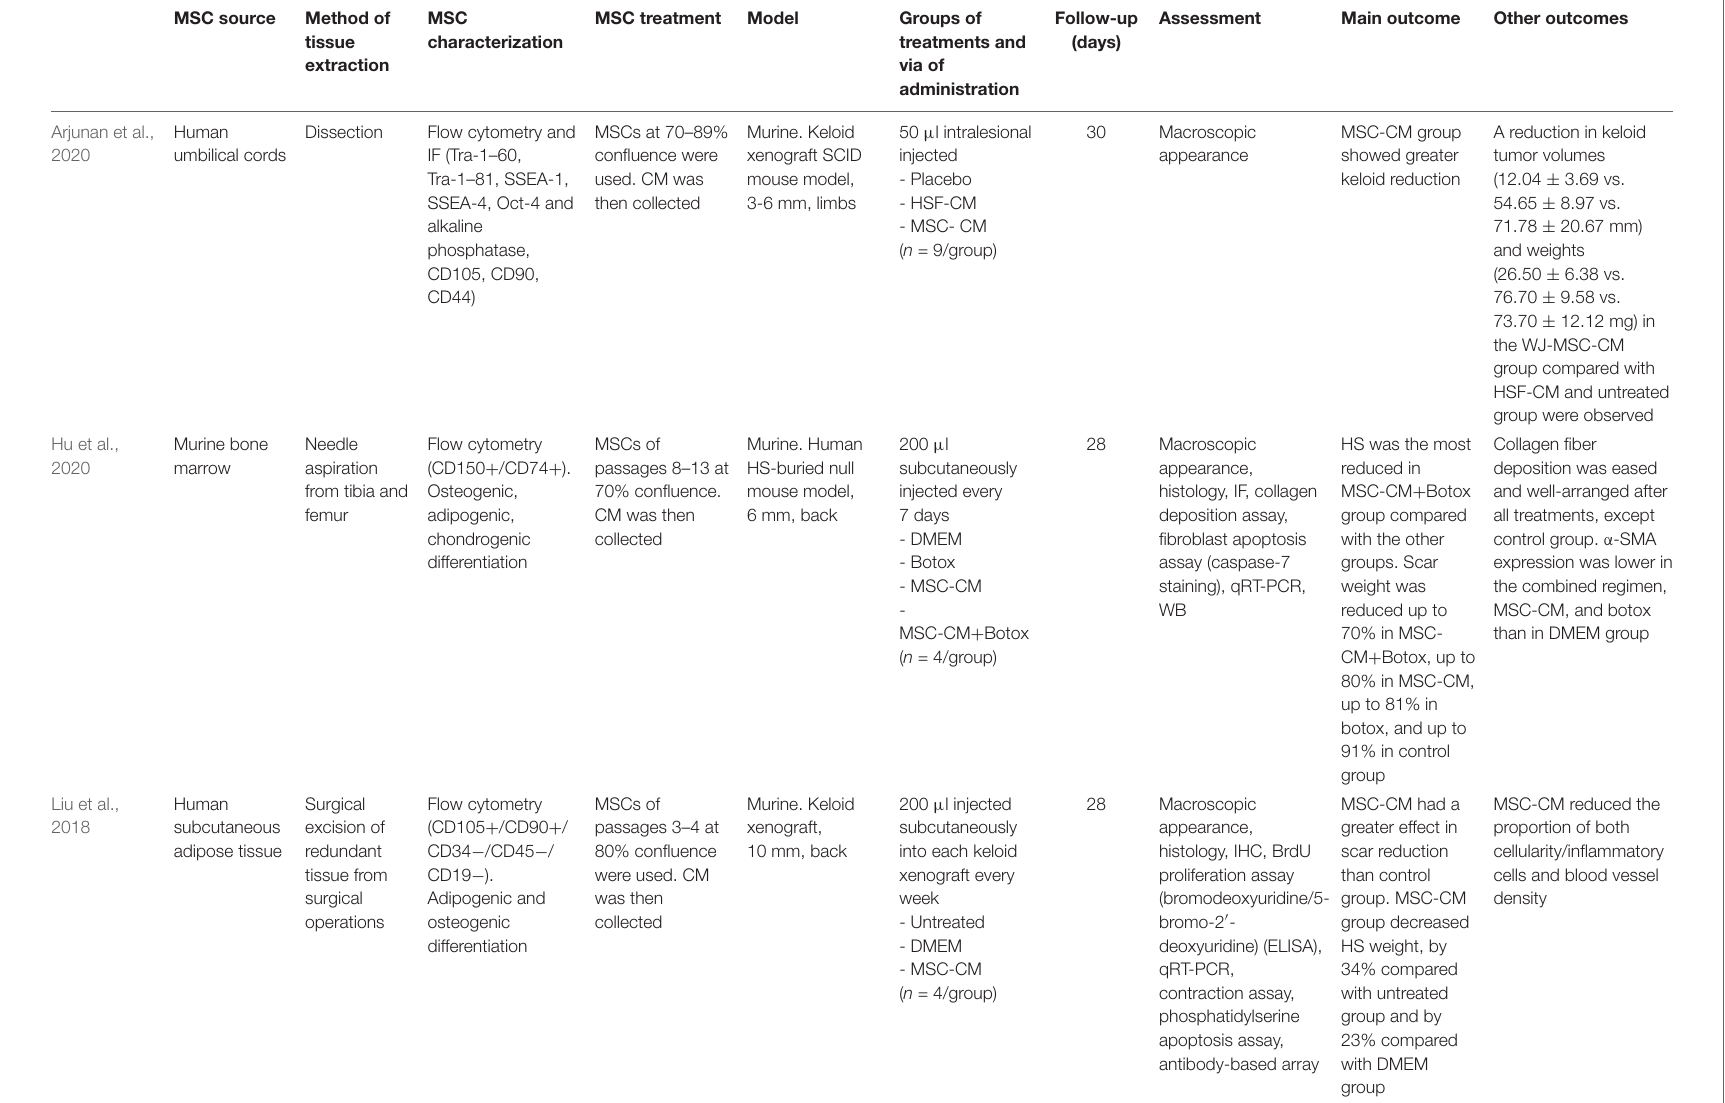
TABLE 5 | Studies regarding mesenchymal stromal cell-conditioned medium for treating hypertrophic scars in animal